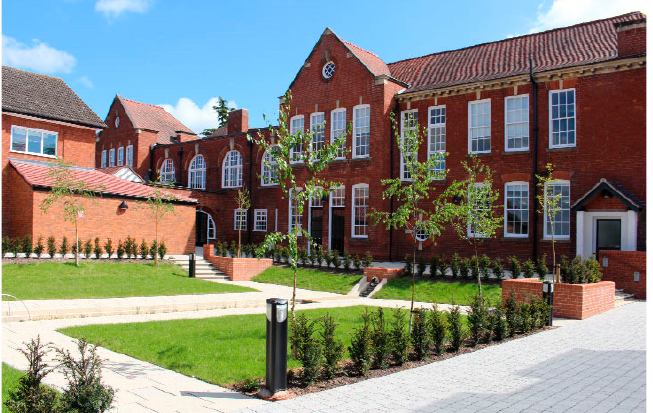
Figure A2. The Courtyard at the Civic Centre.